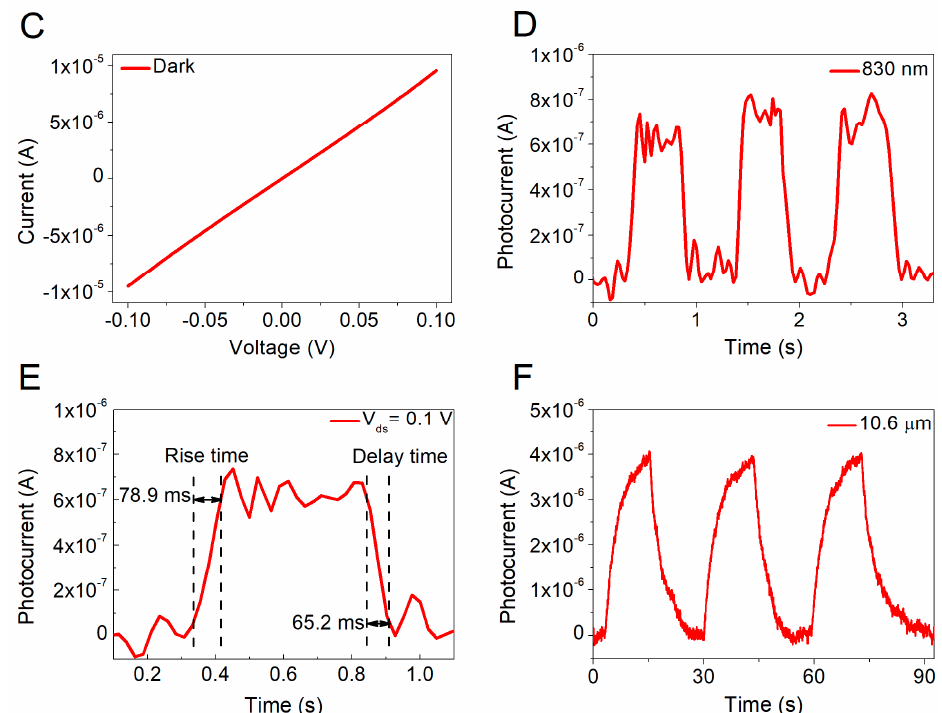
Figure 4. The Photoelectric performance of the NiSe based detector. ( A ) Schematic image of the NiSe photodetector. ( B ) The optical image of the fabricated NiSe device. ( C ) The output curve of a NiSe photodetector without light illumination. ( D ) The time-resolved photoresponse under an 830 nm wavelength illumination at 0.1 V bias. ( E ) The rise time and delay time extracted from the time-resolved photocurrent. ( F ) The time-resolved photoresponse under a 10.6 um wavelength illumination at 0.1 V bias.